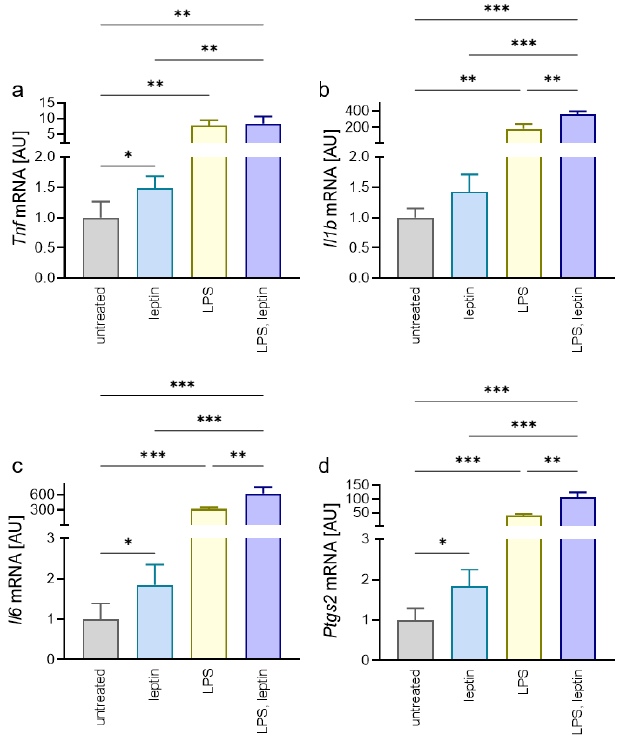
Figure 2. Impact of leptin, Porphyromonas gingivalis LPS and a combination of both on gene expression of Tnf ( a ), Il1b ( b ), Il6 ( c ), and Ptgs2 ( d ) in RAW264.7 macrophages; n = 6; Statistics: Welch-corrected ANOVA with Dunnett’s T3 multiple comparisons test; * p < 0.05, ** p < 0.01, *** p < 0.001.